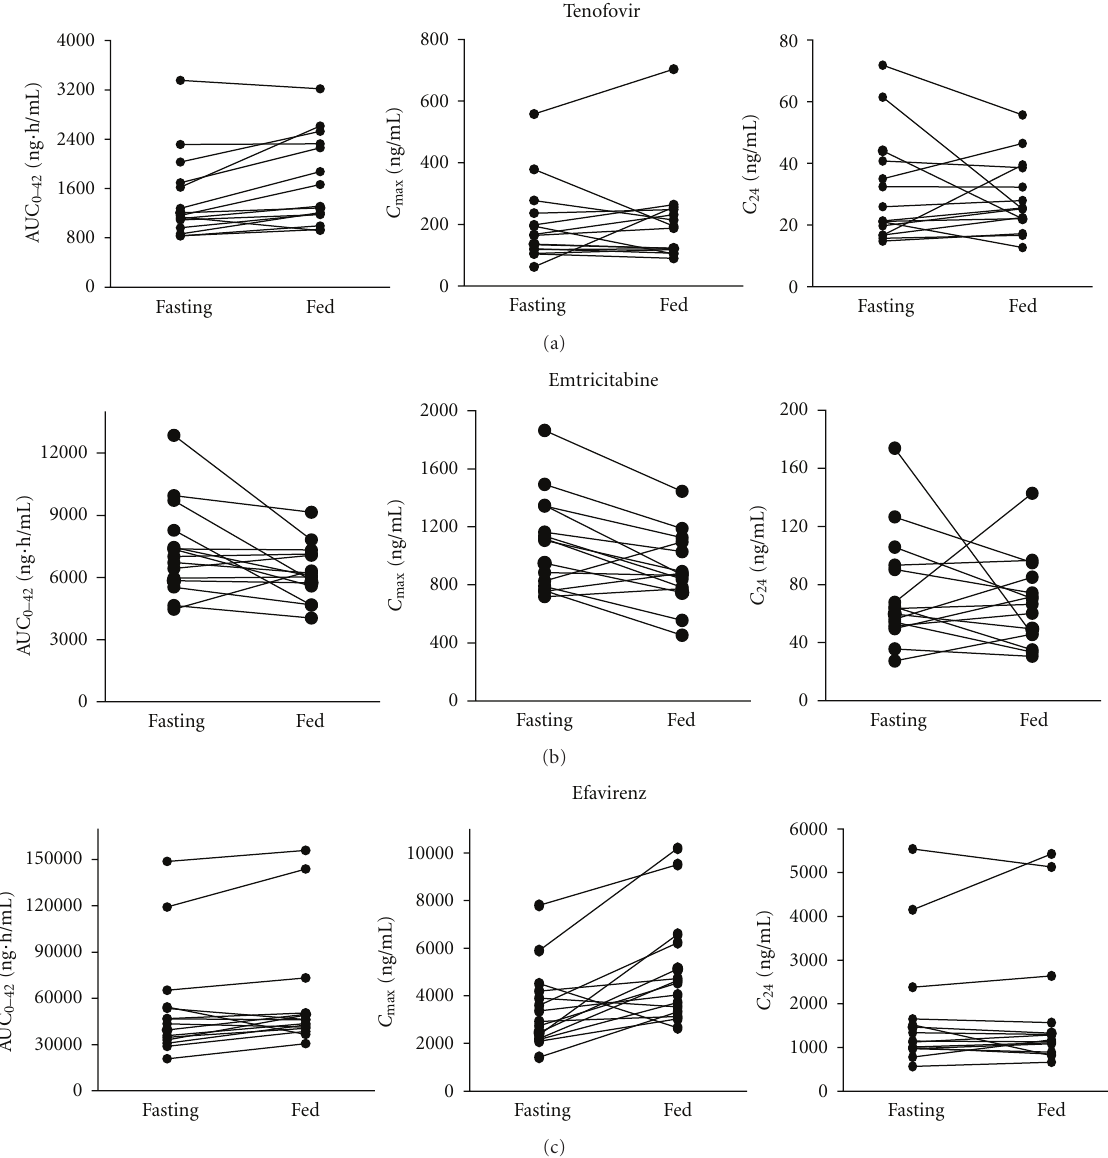
Figure 2: Individual pharmacokinetic parameters for (a) tenofovir and (b) emtricitabine when administered in the fed and fasting states. (c) Individual pharmacokinetic parameters for efavirenz when administered in the fed and fasting